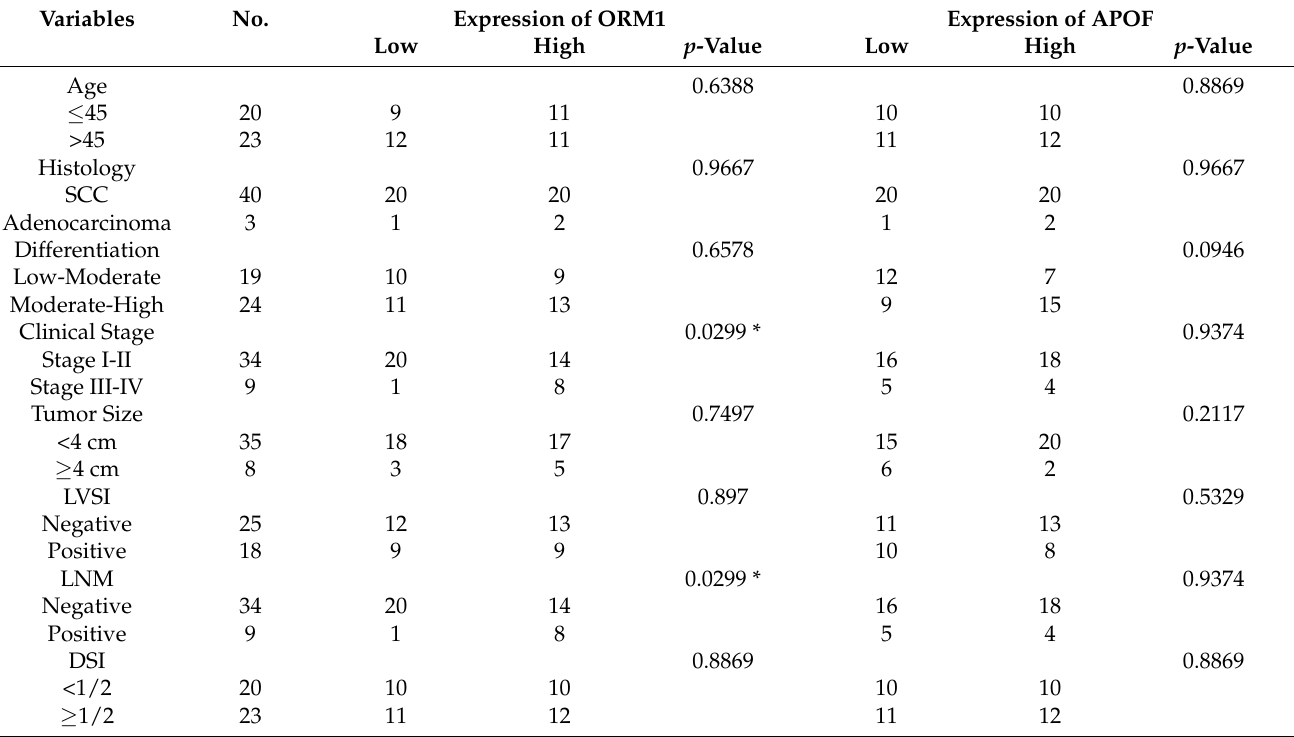
Table 1. Association between ORM1/APOF expression and clinicopathological